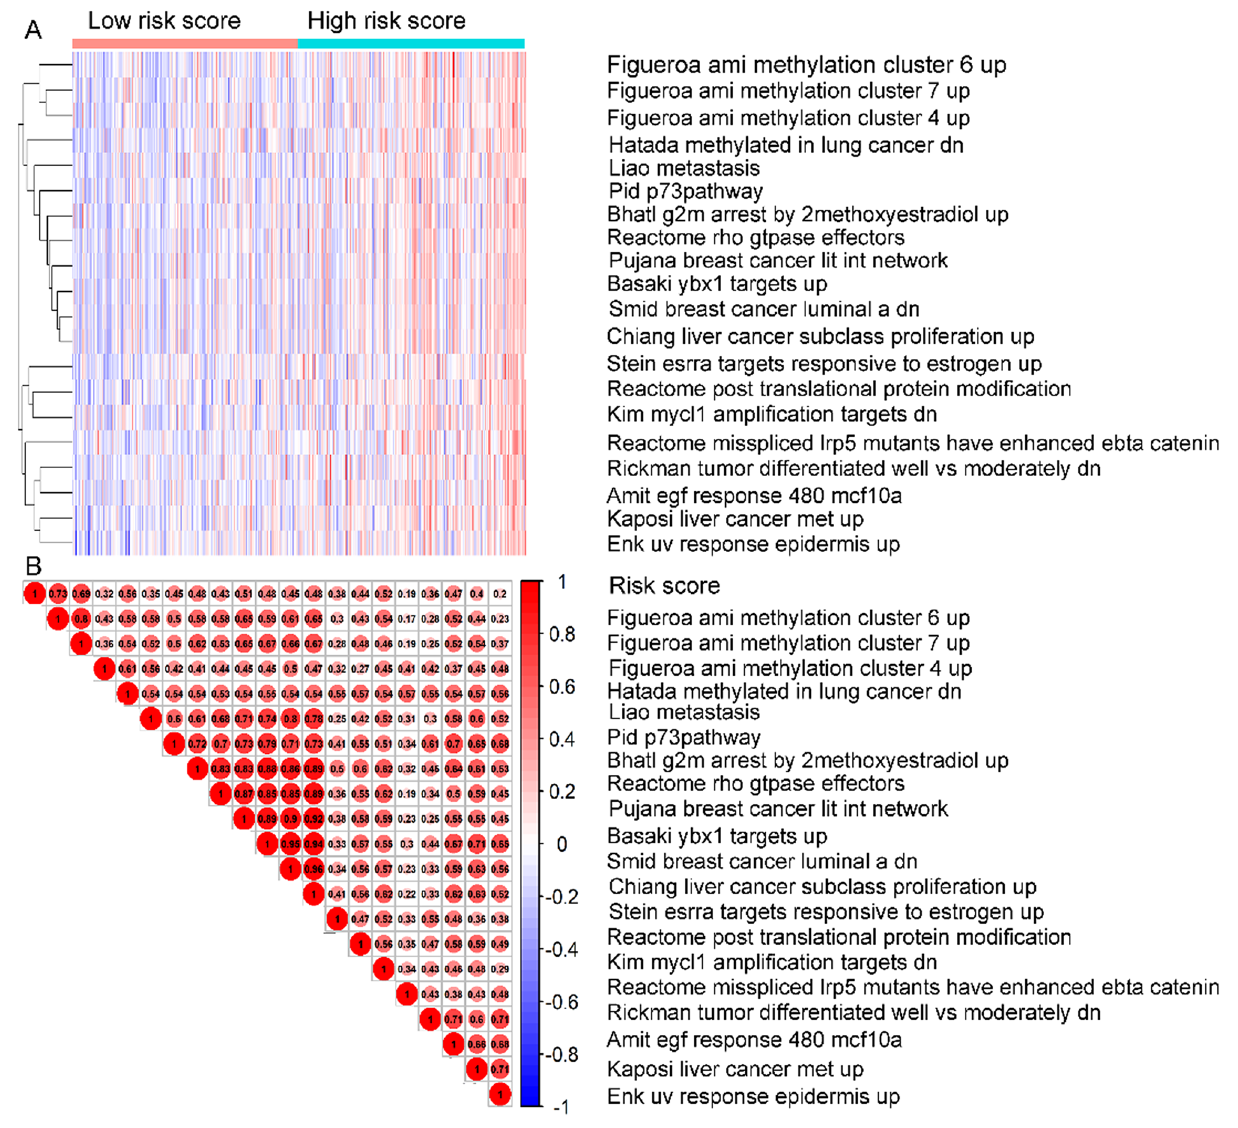
Figure 6. Exploration of the 11 DNA methylation signature-based biological pathways. ( A ) Heatmap of top 20 enriched pathways associated with high risk group. Each row of the heat map represented a pathway and each column represented a stage I–II LUAD sample. ( B ) Correlation graph between risk scores and top 20 pathways. Each red ball represents a pathway, and each transverse line represents one sample. The score characteristic of each sample was shown in the